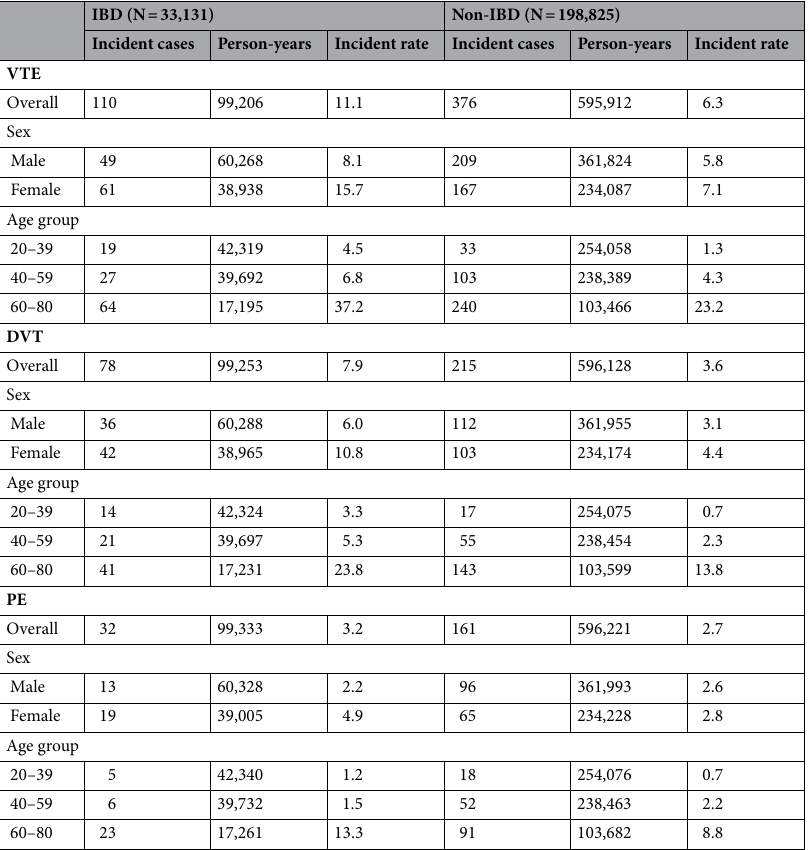
Table 2. Incident cases and incident rates per 10,000 person-years of venous thromboembolism, deep vein thrombosis, and pulmonary embolism in IBD patients and non-IBD controls. IBD inflammatory bowel disease; VTE venous thromboembolism; DVT deep vein thrombosis; PE pulmonary embolism.